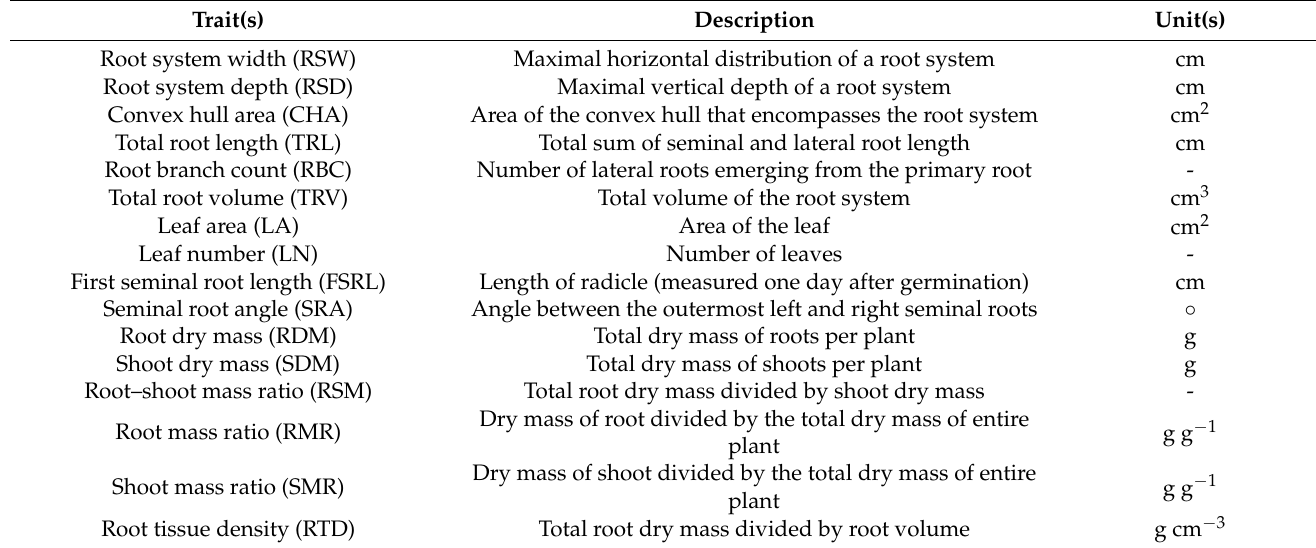
Table 8. Description of measured traits in citron watermelon accessions grown in a root rhizotron and assessed from 8 DAT to 35 DAT under water stress and non-stress